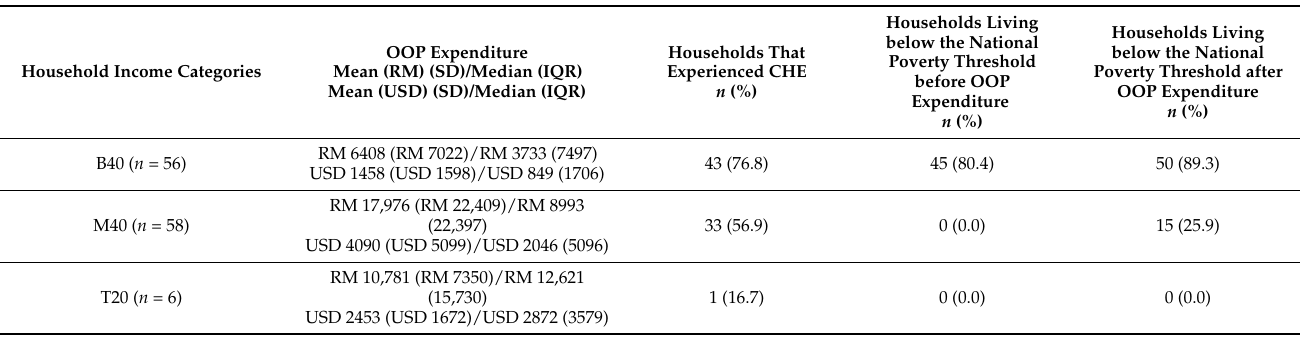
Table 4. Total health-related out-of-pocket expenditure and proportion of households experiencing catastrophic health expenditure and living below the poverty line according to household income categories ( n = 120).